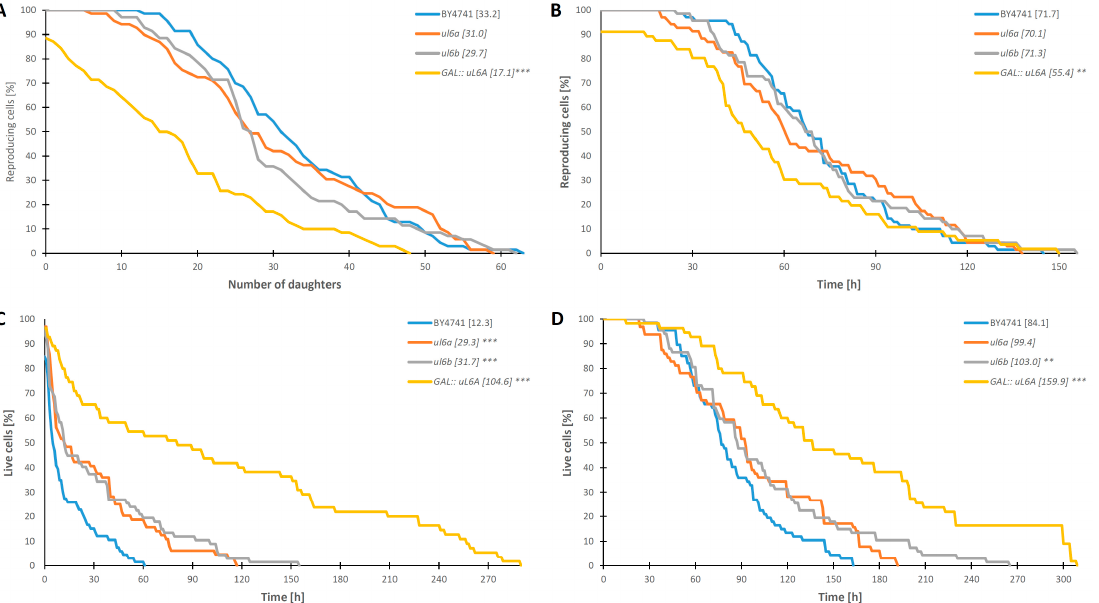
Figure 7. Comparison of the budding lifespan ( A ), reproductive lifespan ( B ), post-reproductive lifespan ( C ) and total lifespan ( D ) of the haploid wild type yeast strain BY4741, isogenic single mutants ∆ ul6A , ∆ ul6B , and the GAL::uL6A mutant after cultivation on solid YPGal media. Statistical significances were assessed using ANOVA and Dunnett’s post hoc test (** p < 0.05, *** p < 0.001). Data represent mean values from two independent experiments. The mean value for total 90 cells from two independent experiments is shown in parentheses.